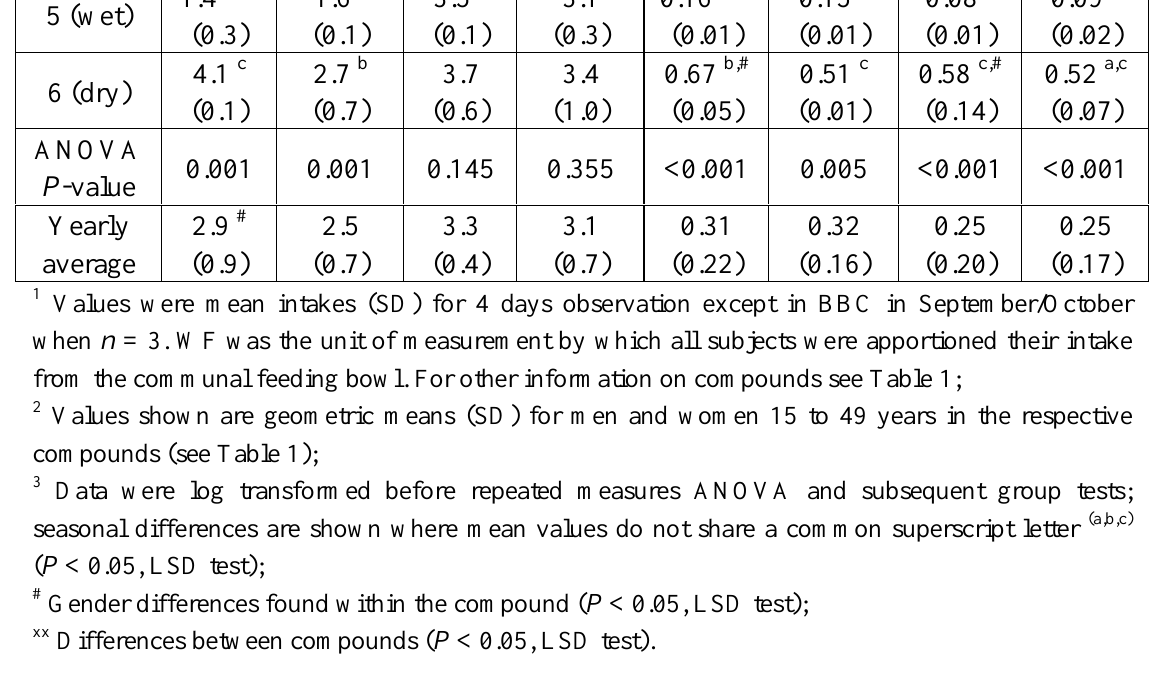
Table 4. Seasonal and gender variations in energy intakes in relation to basal metabolic rates (EI:BMR) of men and women in the study compounds 1,2,3